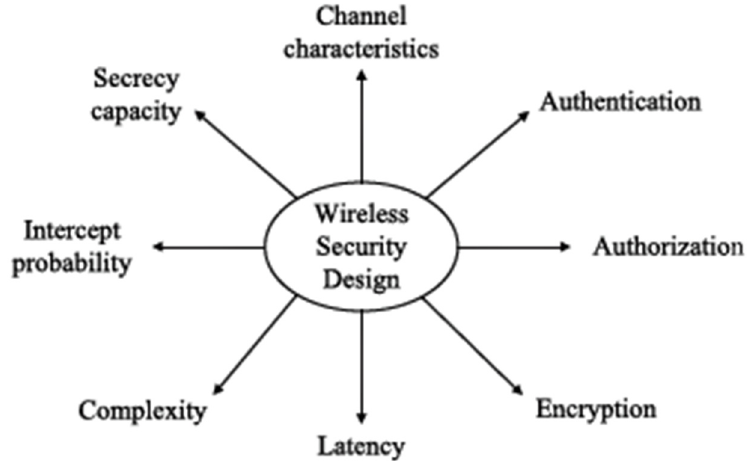
Figure 3. Security vulnerabilities in wireless network.